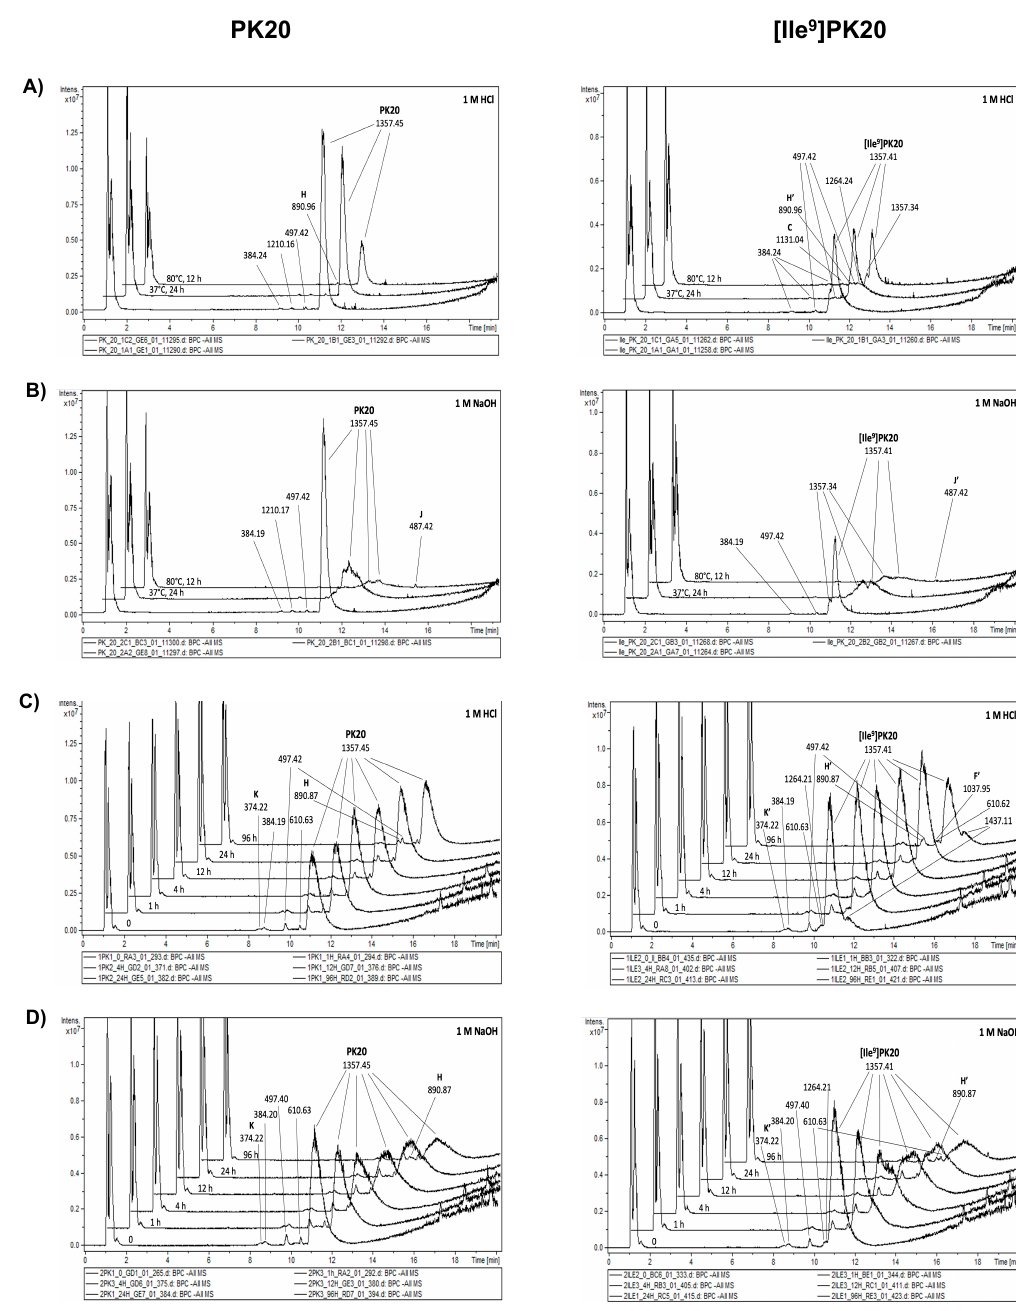
Figure 2. PK20 (panel left) and [Ile 9 ]PK20 (panel right) degradation in acidic (1M HCl) and basic (1M NaOH) conditions depends on: the temperature and time of exposure (panel ( A ) and ( B ), respectively) and time of exposure (panel ( C ) and ( D ), respectively). Chromatograms show degradation products with corresponding molecular